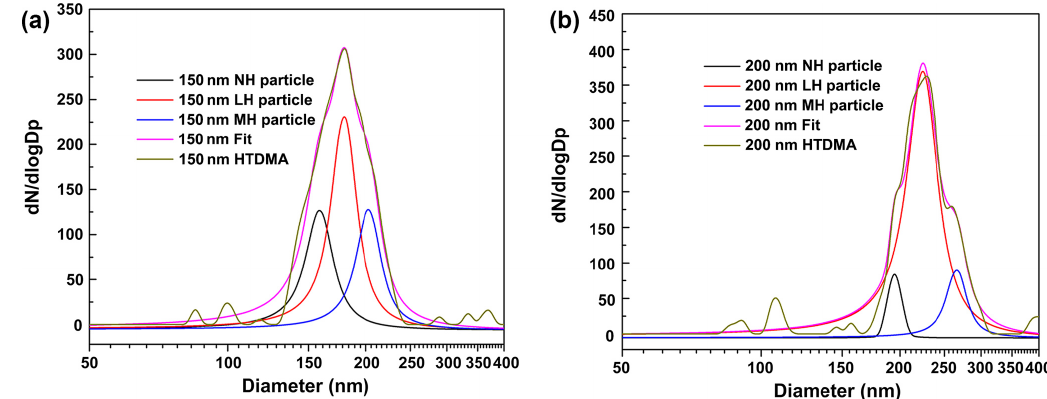
Figure 6. HTDMA and peak fitting reconstruction for (a) 150nm and (b) 200nm atmospheric particles at 84% RH on 28 September 2021.